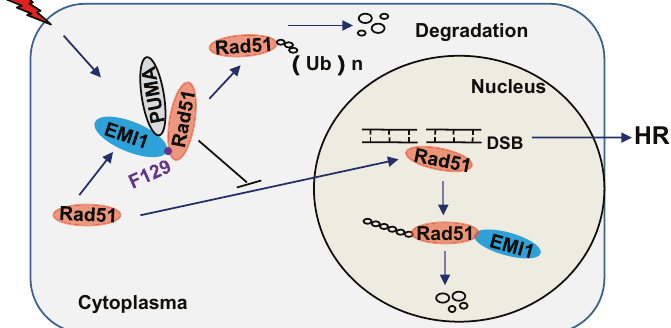
Signal Transduction and Targeted Therapy (2021)